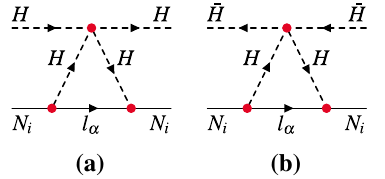
Fig. 1 Forward scattering diagrams with the N i H and N i ¯ H initial states at the O ( Y 2 λ)